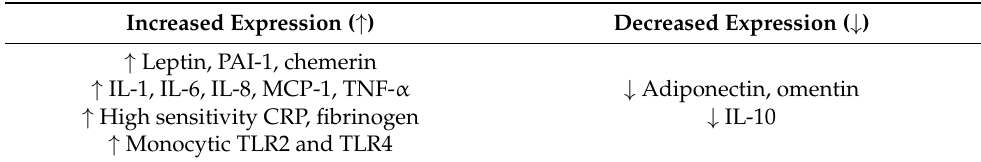
Table 3. Important inflammatory biomarkers and adipokine dysregulation in MetS. ↑ signifies increase. ↓ signifies